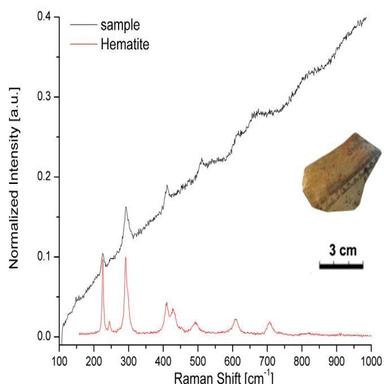
Comparison between Raman spectrum obtained in the red decoration (black) and a reference hematite spectrum (taken from the RRUFF™ Project website database ((http://rruff.info/)ff.info/)) (red) (sample Rip. 19). (For interpretation of the references to color in this figure legend, the reader is referred to the web version of this article.)